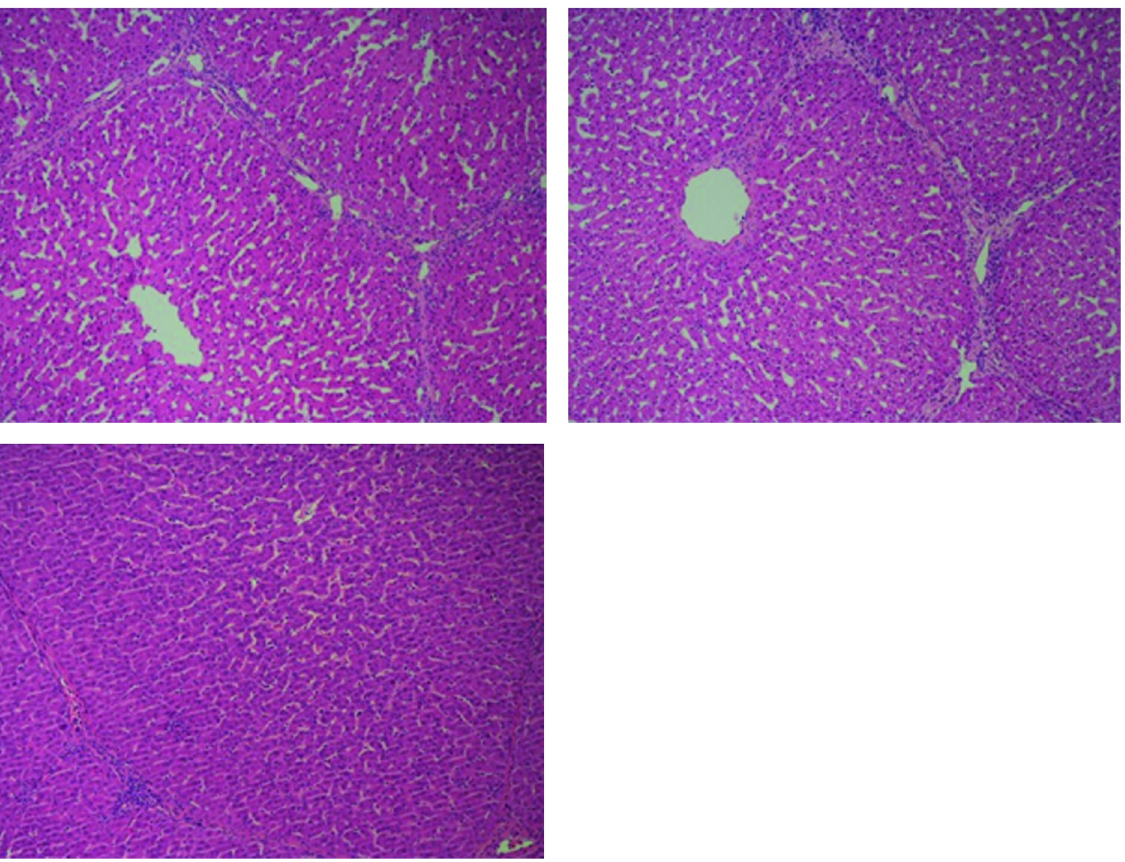
Fig 10. Histological appearance of liver parenchyma. (A) Biopsy at baseline(followingdonor hepatectomy), (B) Biopsy taken after 48 hours of organ preservation by normothermic machineperfusion, (C) post-mortem biopsy after five days of recipientfollow-